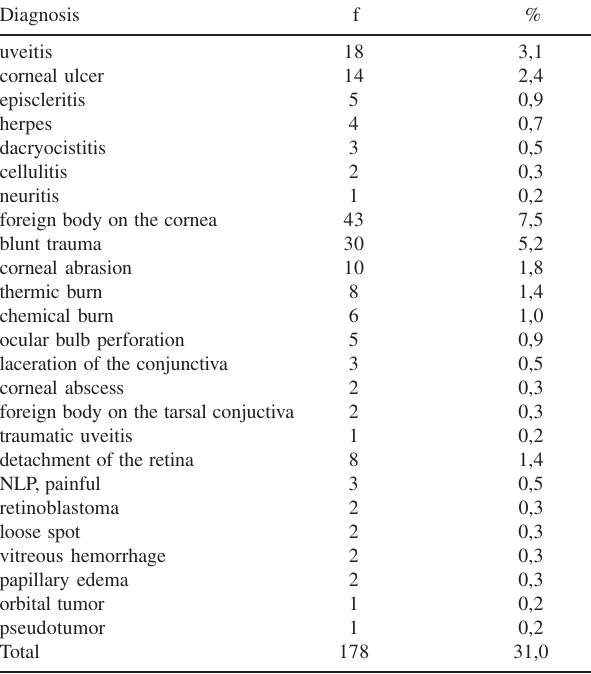
Table 6 - Diagnosed urgent cases requiring treatment in tertiary care units - patients that looked for